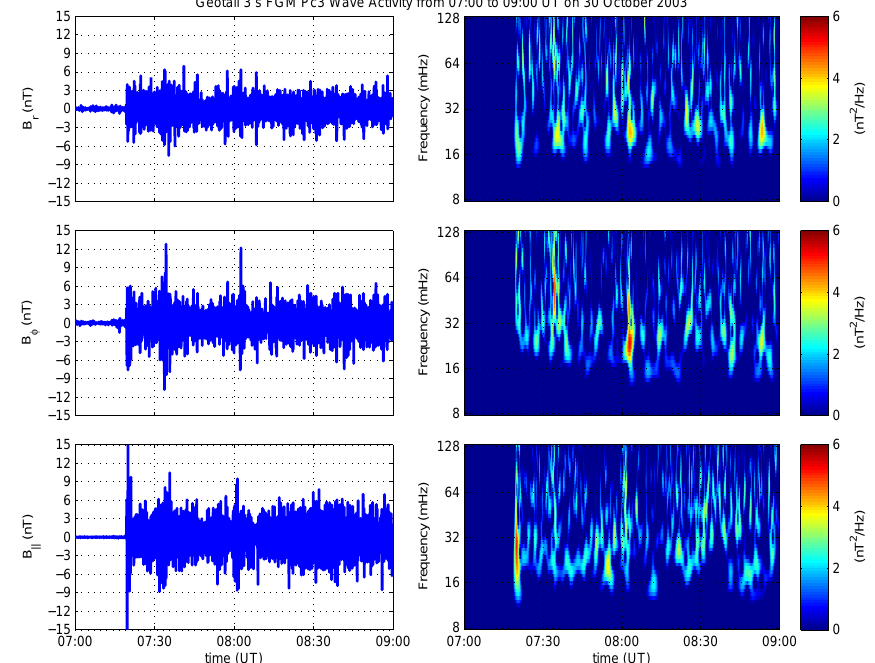
Fig. 9. Event 1: 07:00–09:00UT, 30 October 2003. As in Fig. 7 but for the Geotail Pc3